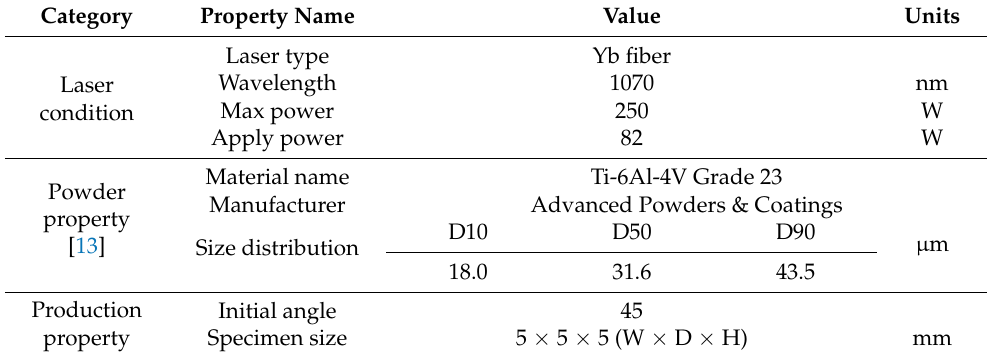
Table 2. Process parameters for specimen printing